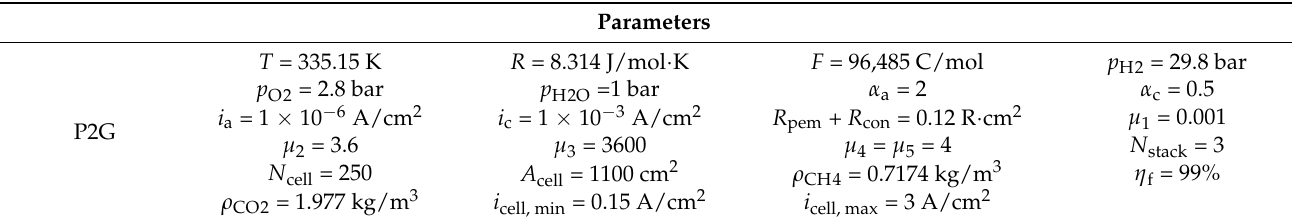
Table 1. Parameters of P2G